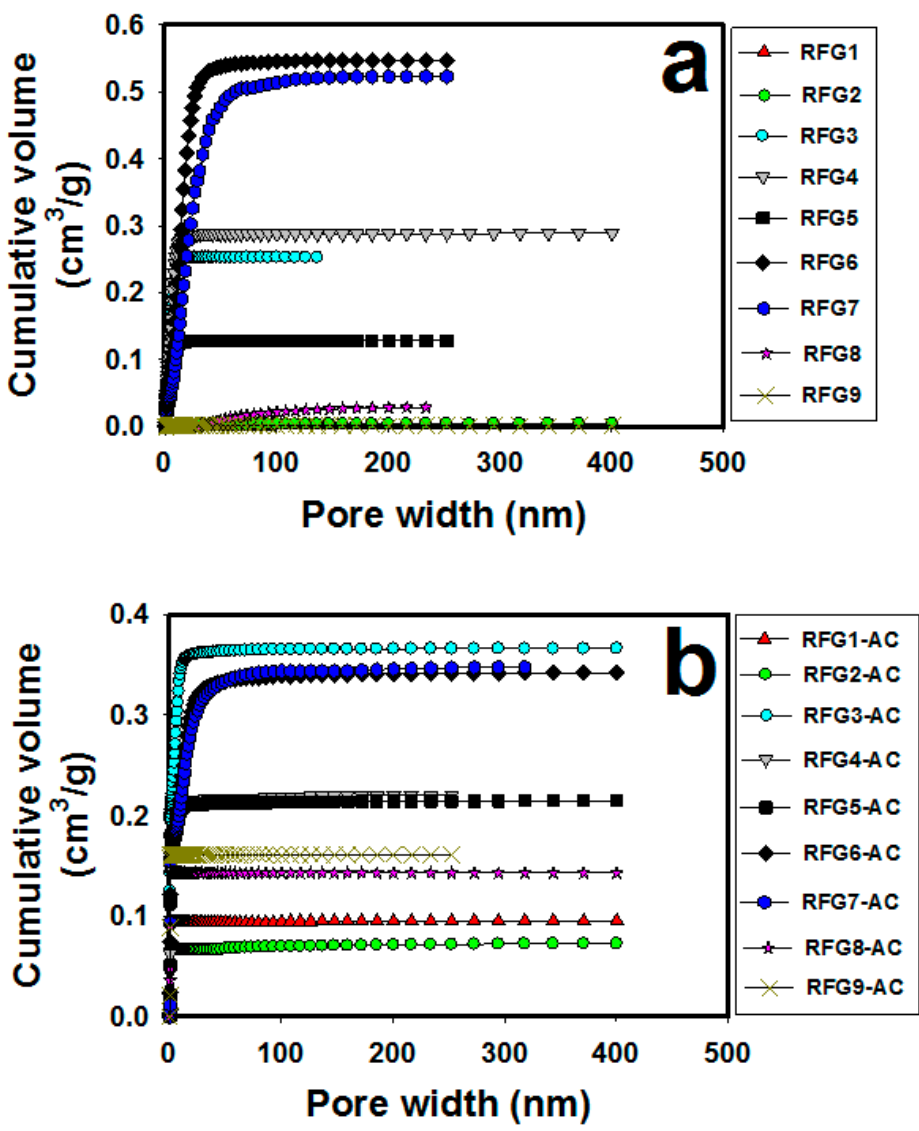
Figure 10. Cumulative pore volume area versus pore width of ( a ) RFG n and ( b ) RFG n -AC samples.